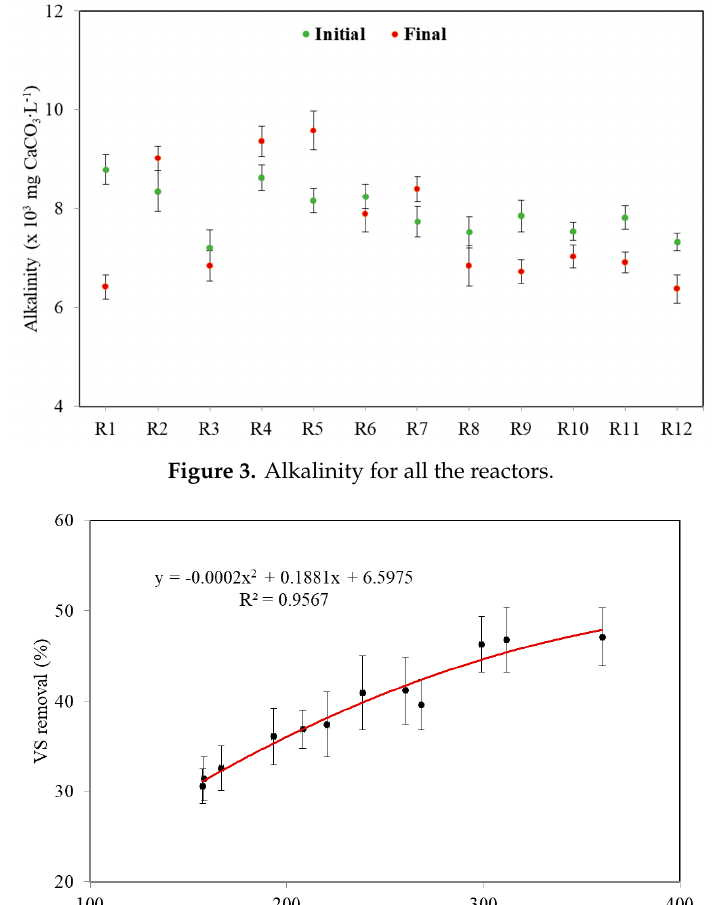
Figure 4. Correlation of biogas produced per g volatile solids (VS) and percentage of VS removal for all the experiments.